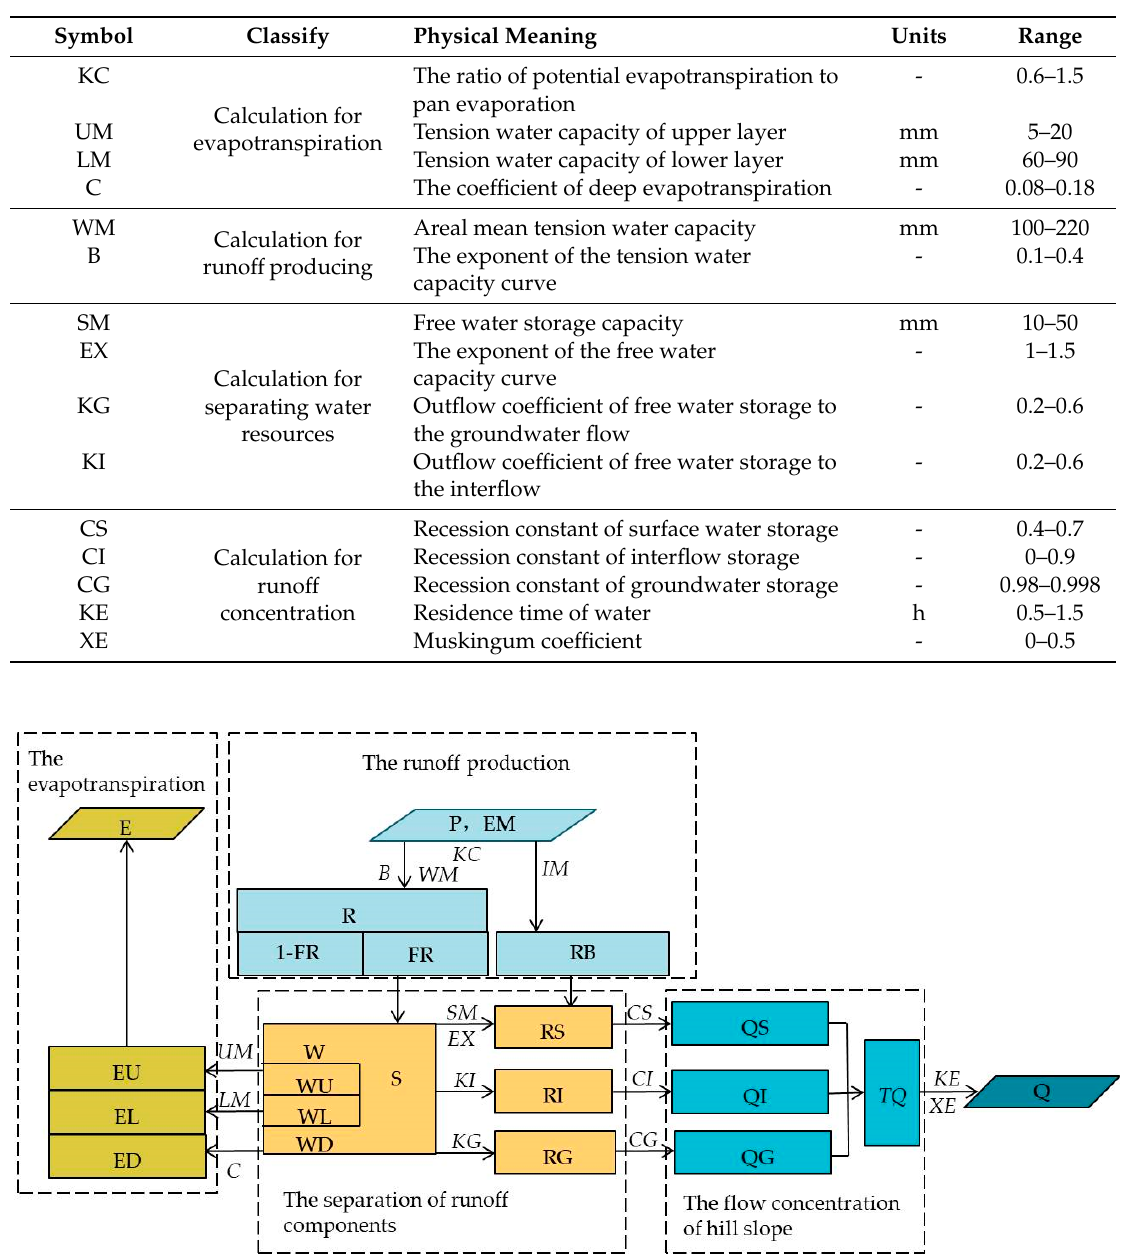
Table 3. Parameters in Xinanjiang model.